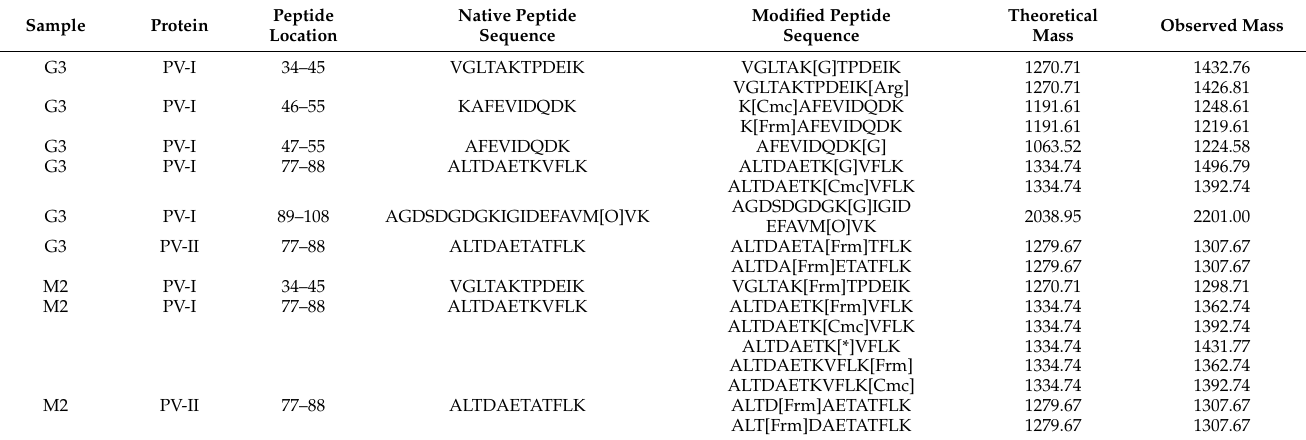
Table 2. Summary of the theoretical and observed tryptic peptide masses from parvalbumin isoforms PV-I and PV-II in the samples G3 and